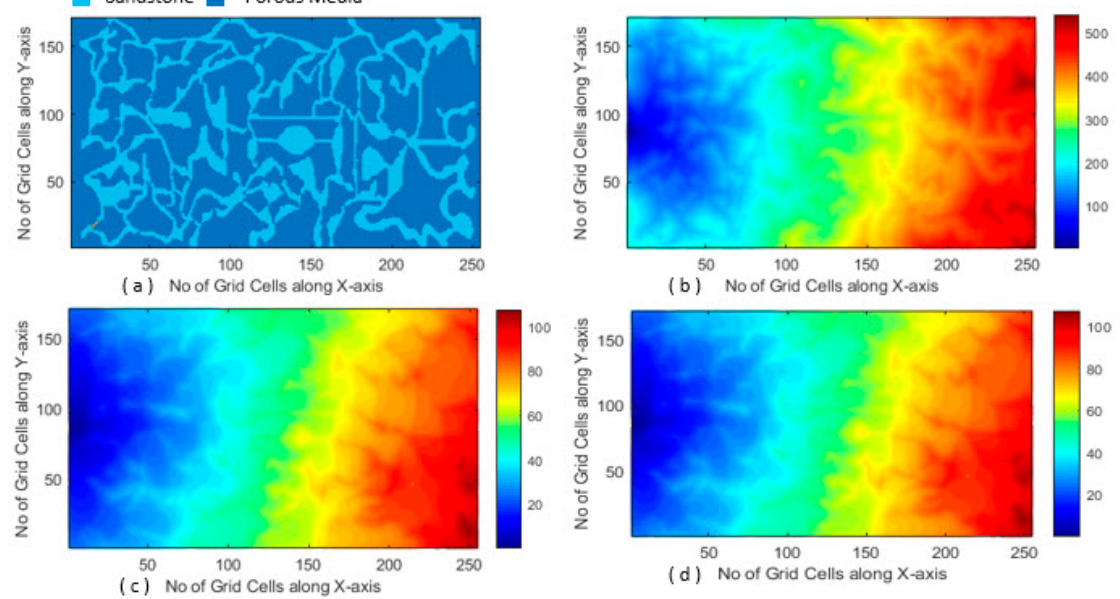
Figure 9. ( a ) Structure of porous medium and magnetic-field distribution in porous medium filled with ( b ) air, ( c ) oil, and ( d ) brine.